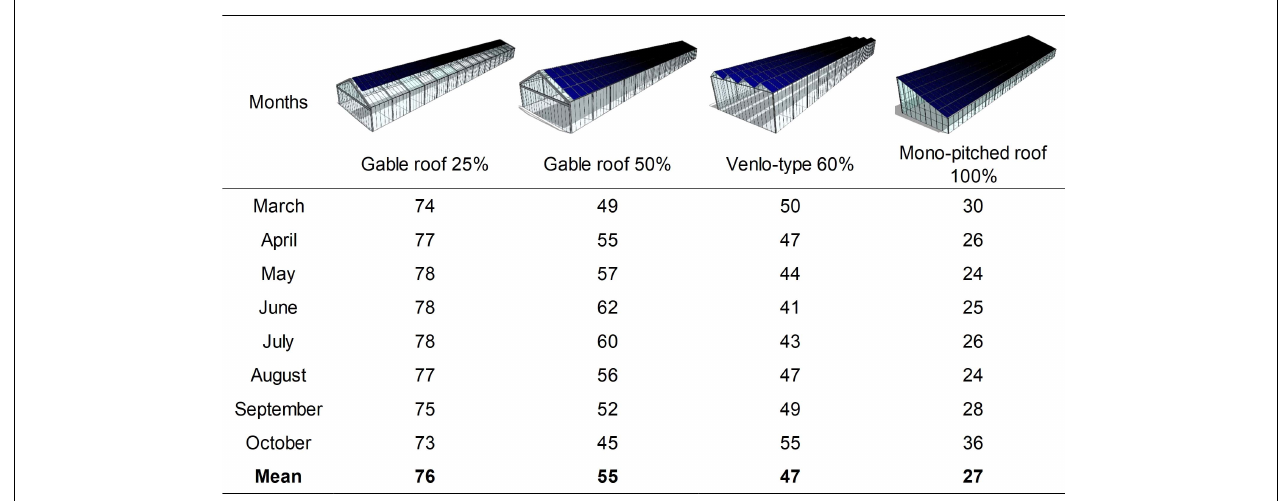
FIGURE 2 | Average monthly percentage of available cumulated PAR from March to October compared with a conventional greenhouse without PV panels on the roof, expressed as GGR coefficients for four photovoltaic greenhouse (PVG) types with E–W orientation. The coefficients were calculated at 1.5 m above ground level and retrieved from the literature (Cossu et al.,